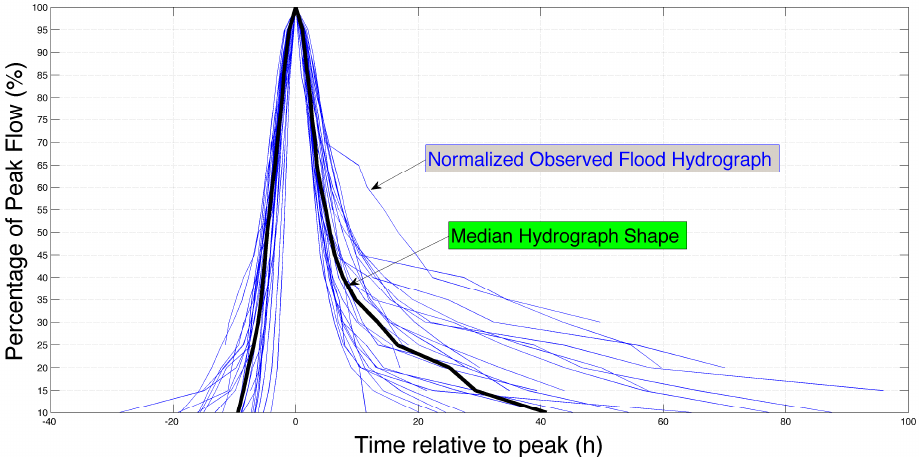
Figure 3. Deriving median durations for each exceedance percentile to determine median hydrograph